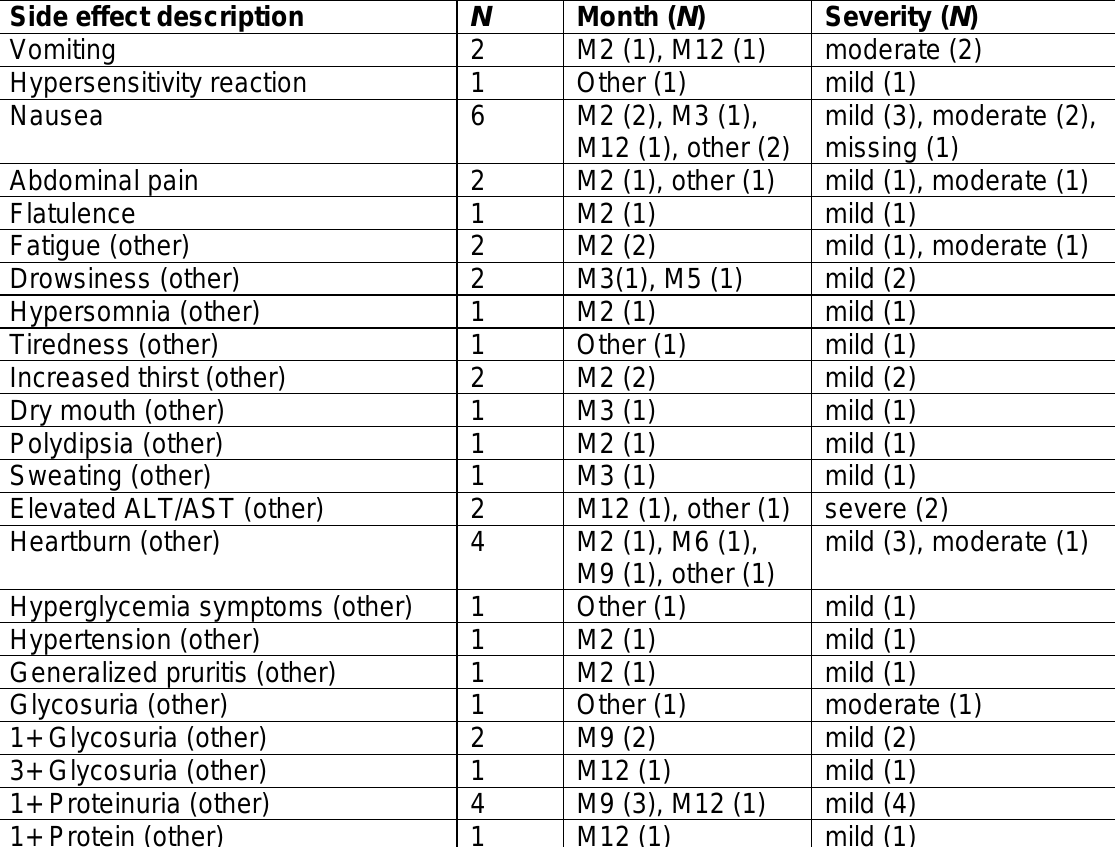
TABLE 2-A1. Side effects among South African men who have sex with men and transgender women in a combination HIV prevention trial,